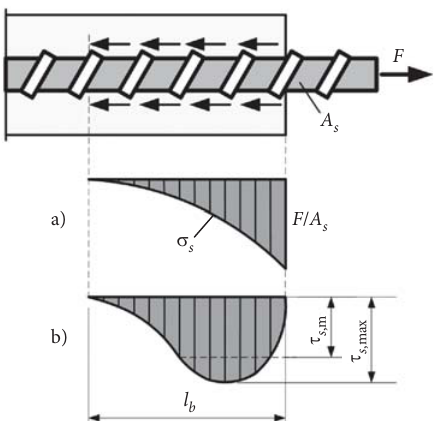
Fig. 1. Distribution of stress of the pulling-out the bar of carbon FRP bar from the concrete: a – normal stress,